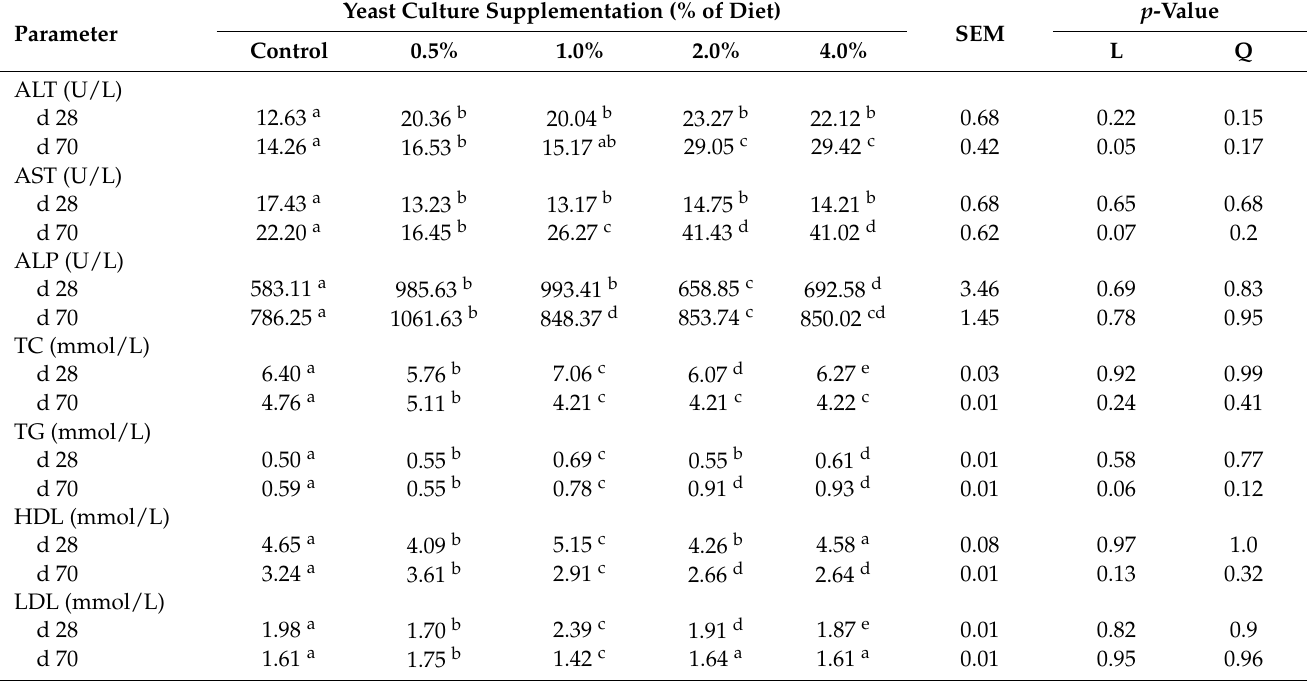
Table 5. Effect of yeast culture supplementation in goose diets on serum